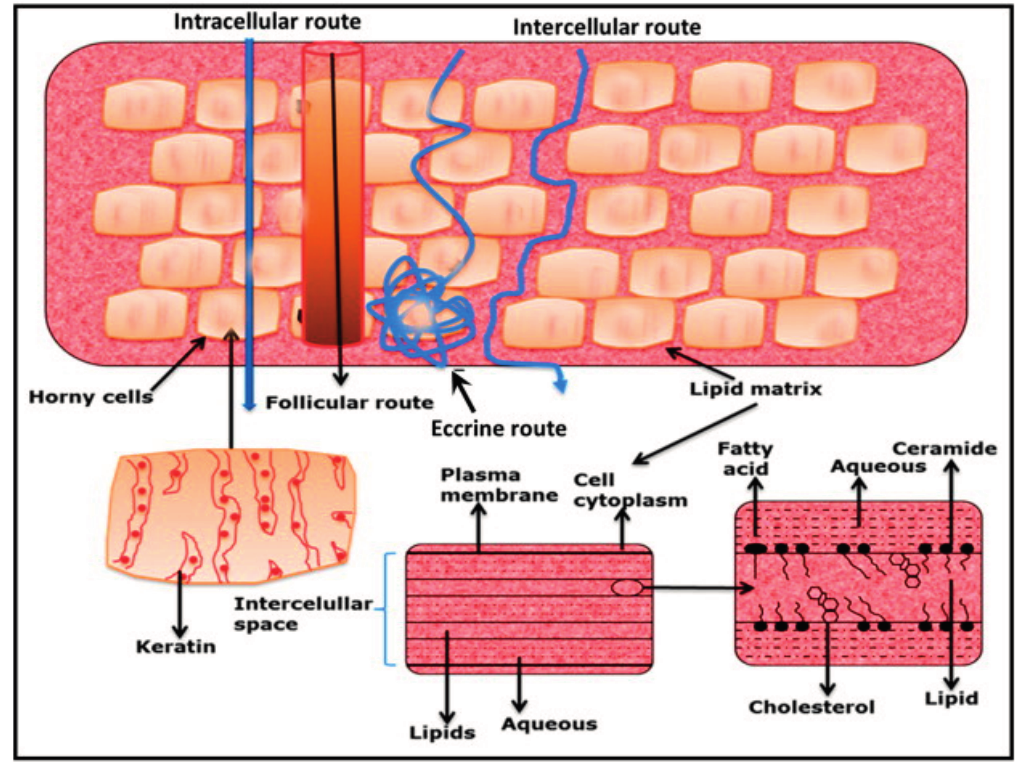
Figure 2. Possible drug penetration routes across human skin. (Reprinted from [30] with permission. Copyright 2012